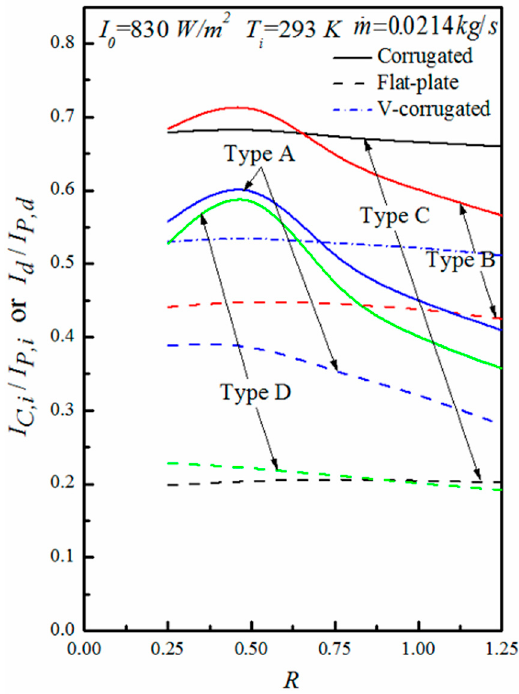
Figure 15. The ratio of the collector efficiency improvements and power consumption increments ( ṁ = 0.0214 kg/s).